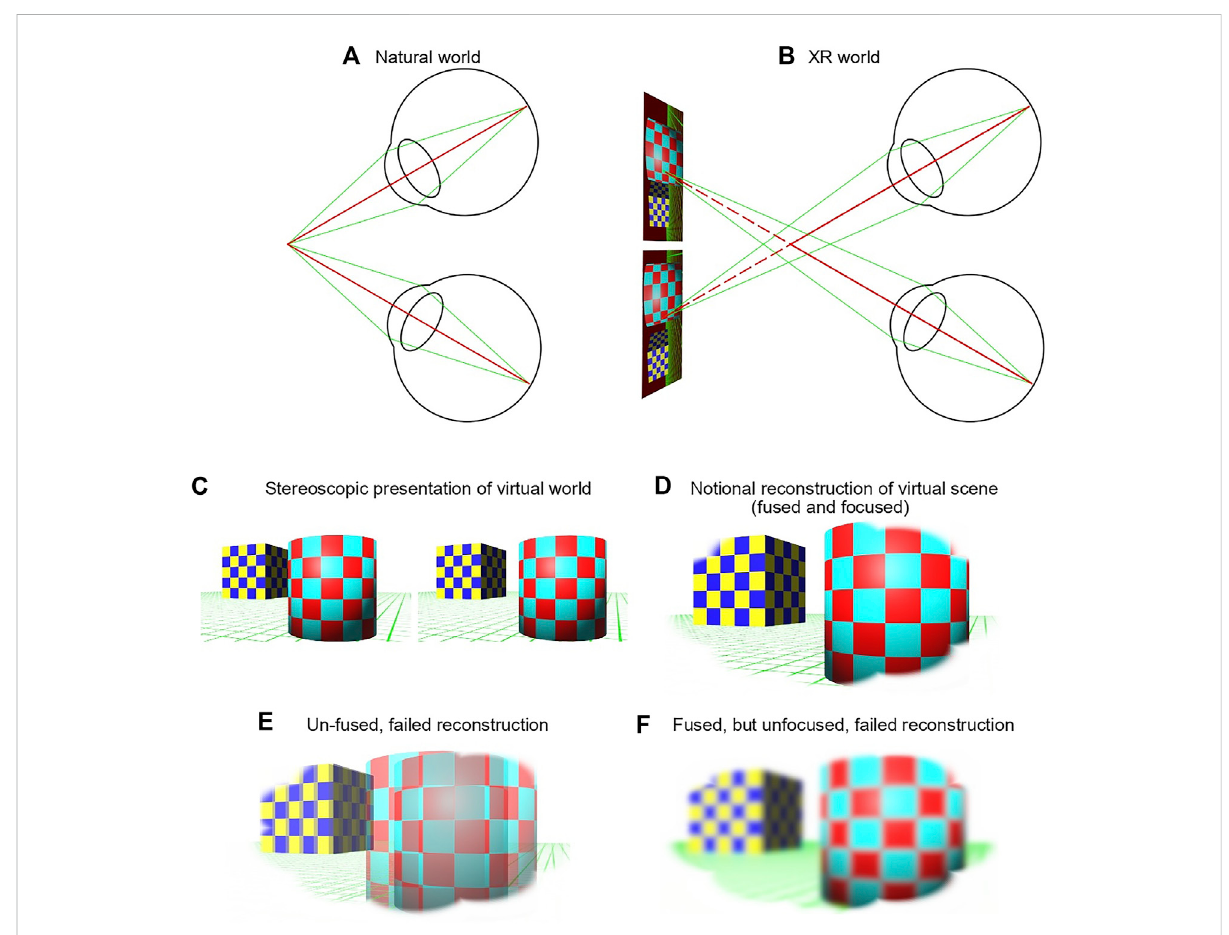
FIGURE 2 (A) In the natural world, when fi xating on a real object, the eyes accommodate (green lines) and converge (red lines) appropriately for that object ’ s distance. (B) In XR, the focal distance of all virtual objects is the same as the focal distance of the HMD (typically, 2 m) irrespective of the objects ’ distances. When fi xating on a virtual object, the eyes need to accommodate at 2 m, while converging appropriately for the virtual object ’ s distance, here nearer than 2 m, resulting in a vergence-accommodation con fl ict. A user may be able to construct a single 3D perceptfrom two monocular virtual scenes (B and C) , if unaffected by the con fl ict, the user perceives a single, focused image (D) . If the user fails to overcome the vergence-accommodation con fl ict, then this may result in an un-fused image which appear double (E) or a fused image which appear blurred (F)